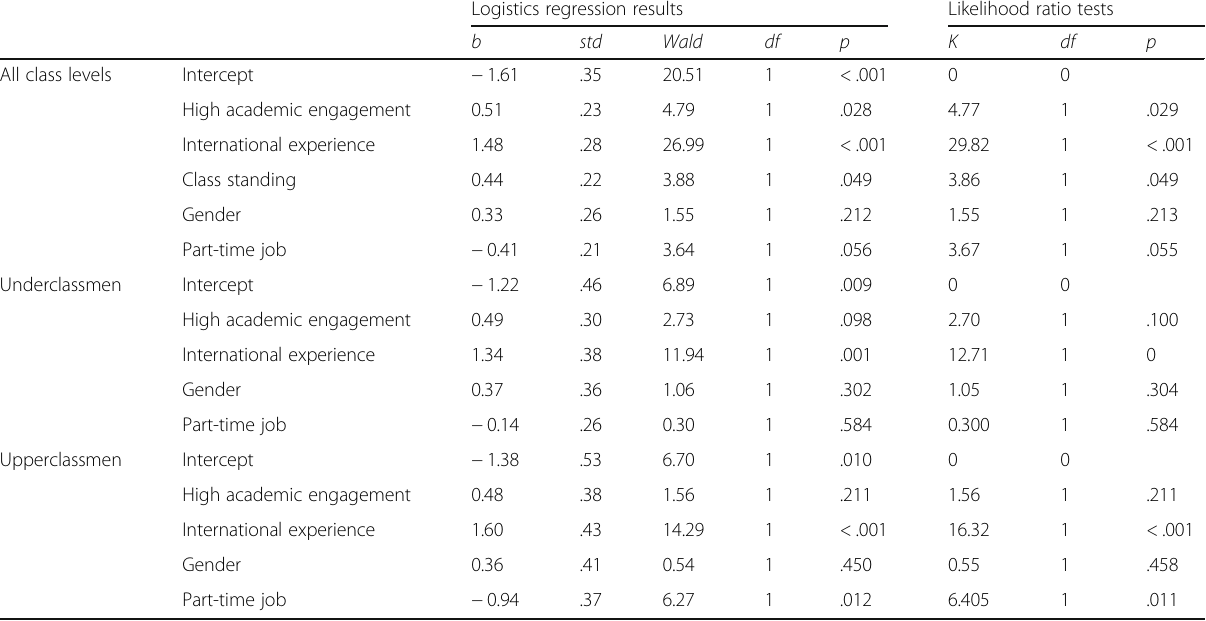
Table 10 Results of the logistics regression